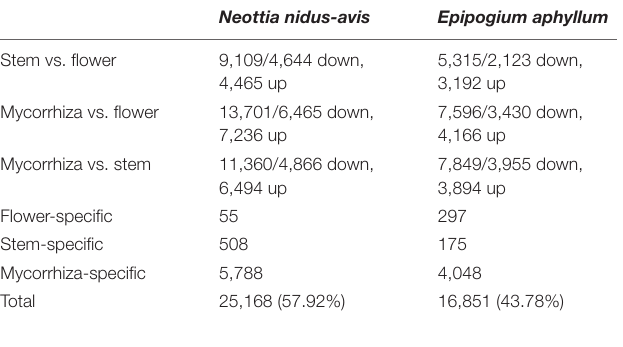
TABLE 3 | Summary of differential gene expression analyses among the sampled